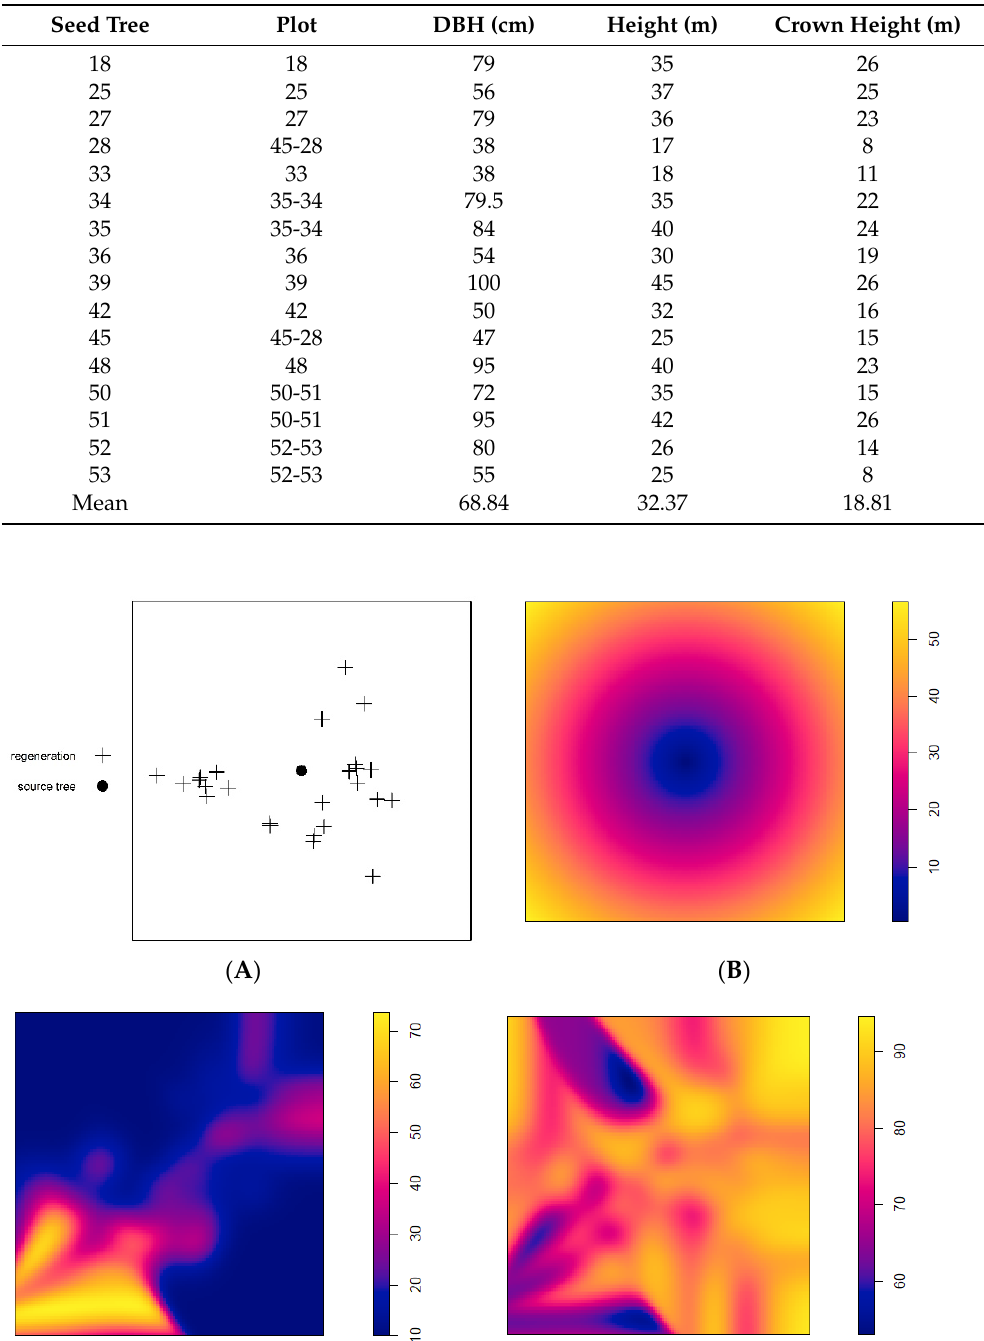
Figure 2. Frequency distributions (percent) of the distance to adult conspecifics for seedlings of V. odorata in four height classes. The median distance between a seedling and the nearest adult tree is also shown.